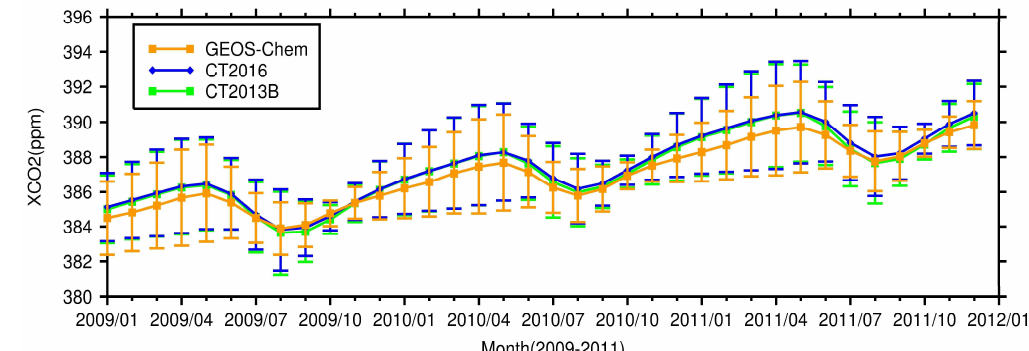
Figure 8. The time series variations of monthly averaged XCO 2 and standard deviation for 2009–2011 among CT2013B, CT2016 and GEOS-Chem on the global scale. The orange line is the XCO 2 simulated from GEOS-Chem; the blue line refers to XCO 2 simulated from CT2016; the green line is the XCO 2 of CT2013B. Unit: ppmv.